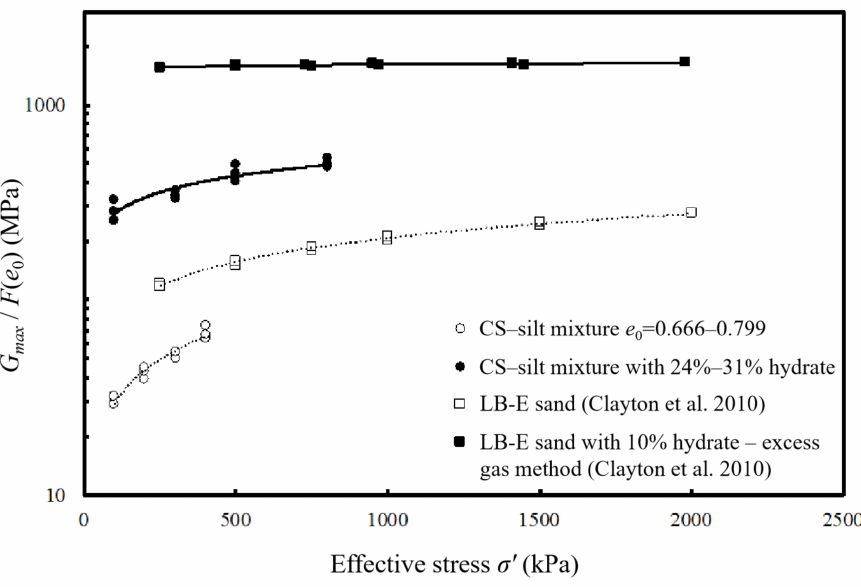
Figure 6. Relationship between the normalized maximum shear modulus and the effective stress